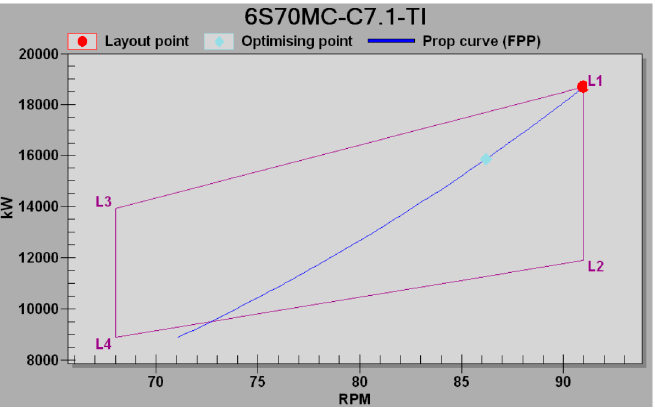
Figure 2. The quad of mean effective pressure and engine speed with chosen nominal continuous rating (NCR) [27].